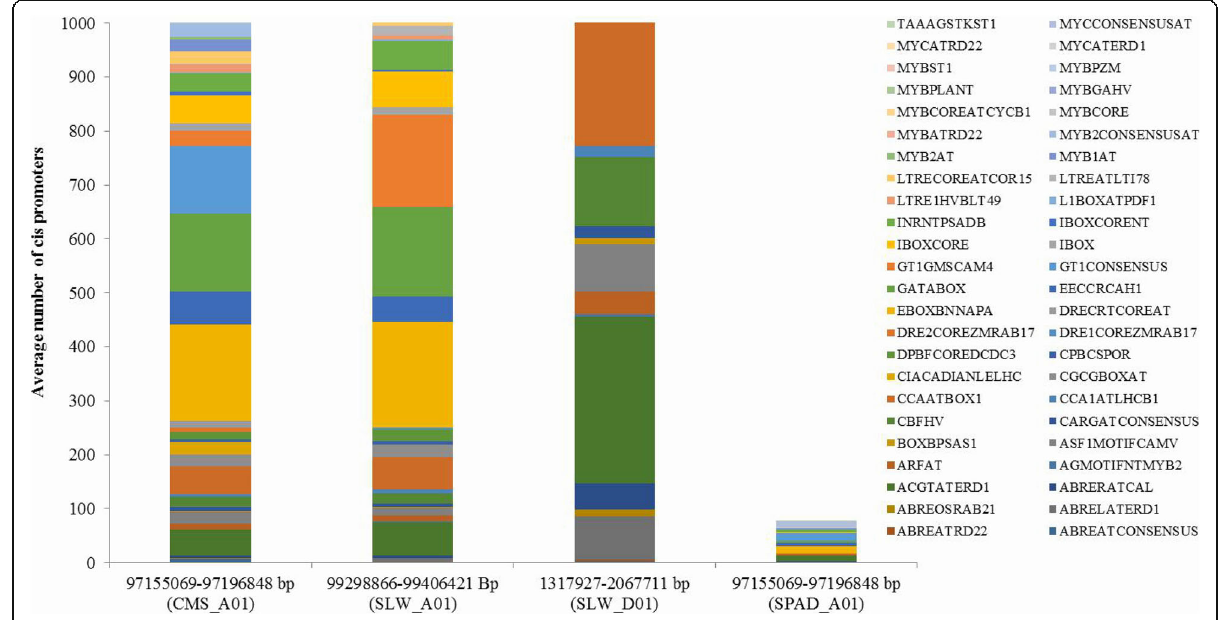
Fig. 5 Average number of the cis-promoters. MYBCORE (TAACTG), TAAAGSTKST1 (TAAAG), ABRELATERD1 (ACGTG), GT1CONSENSUS (GRWAAW), DRECRTCOREAT (G/ACCGAC), LTRE1HVBLT49 (CCGAC) and others in promoter region of Gossypium hirsutum mined genes within the three major QTL clusters for cell membrane stability (CMS), saturated leaf weight (SLW_chrA01/chr15_D01) and Chlorophyll as determined through SPAD values. The promoter regions were analyzed in the 1 kb upstream promoter region of translation start site using the PLACE